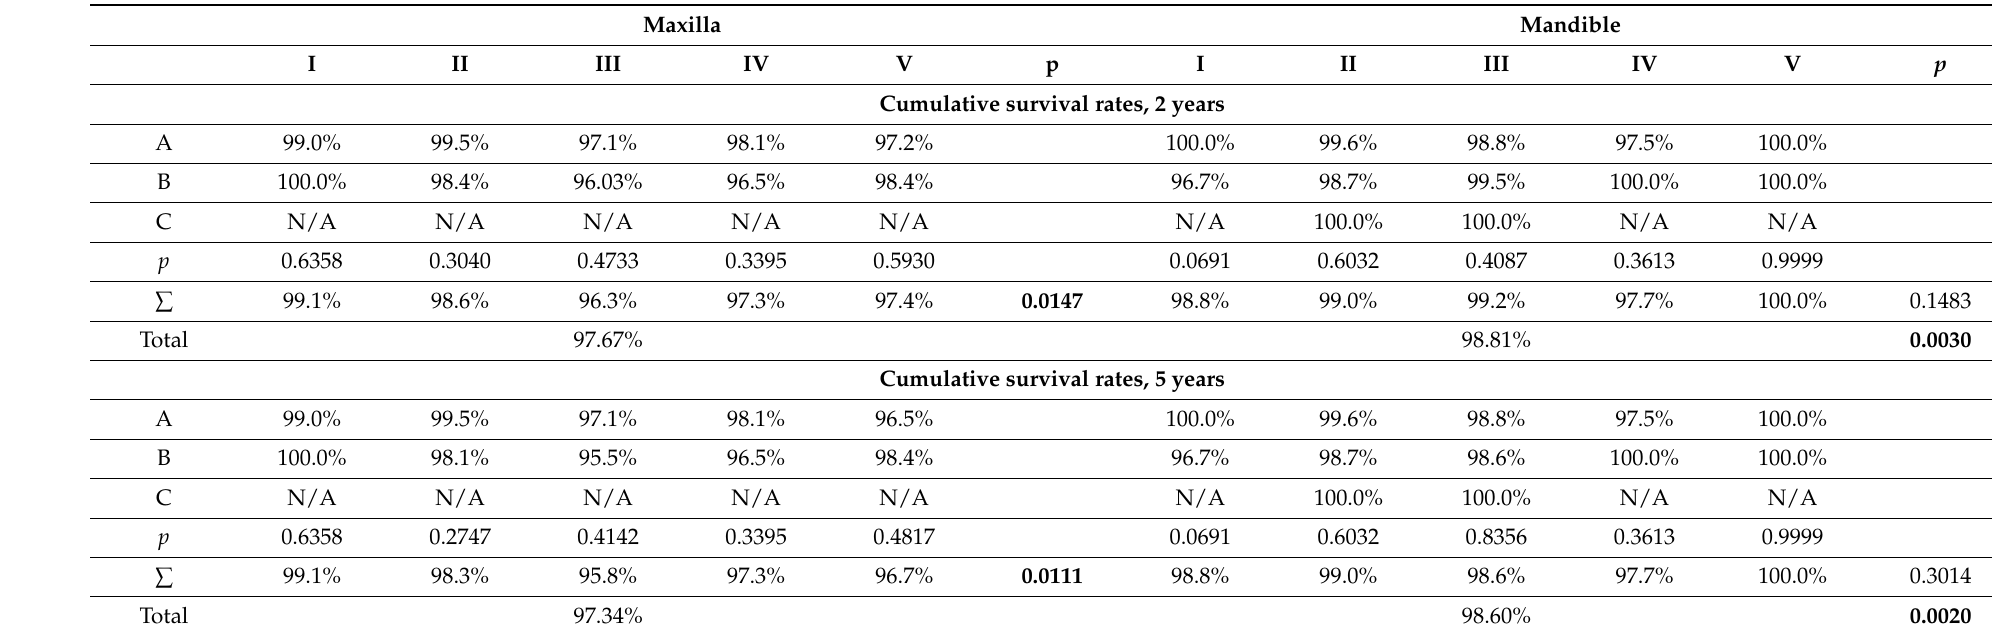
Table 5. Cumulative implant survival rates (CSRs) as derived from the Kaplan–Meier survival analysis. Values refer to individual TOs and CCs (cumulated over individual TOs); p -values represent log-rank values; p -values indicating statistical significance are marked in